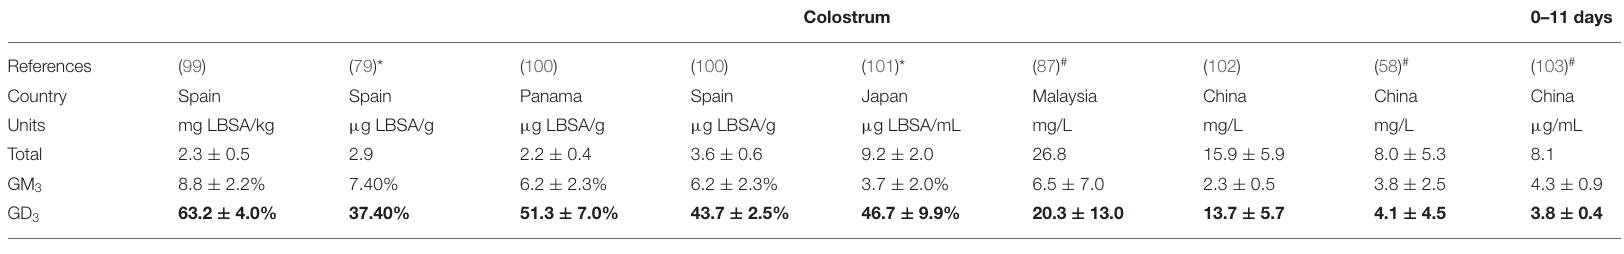
TABLE 3 | Concentration of ganglioside molecular structures in human colostrum, transitional, and mature